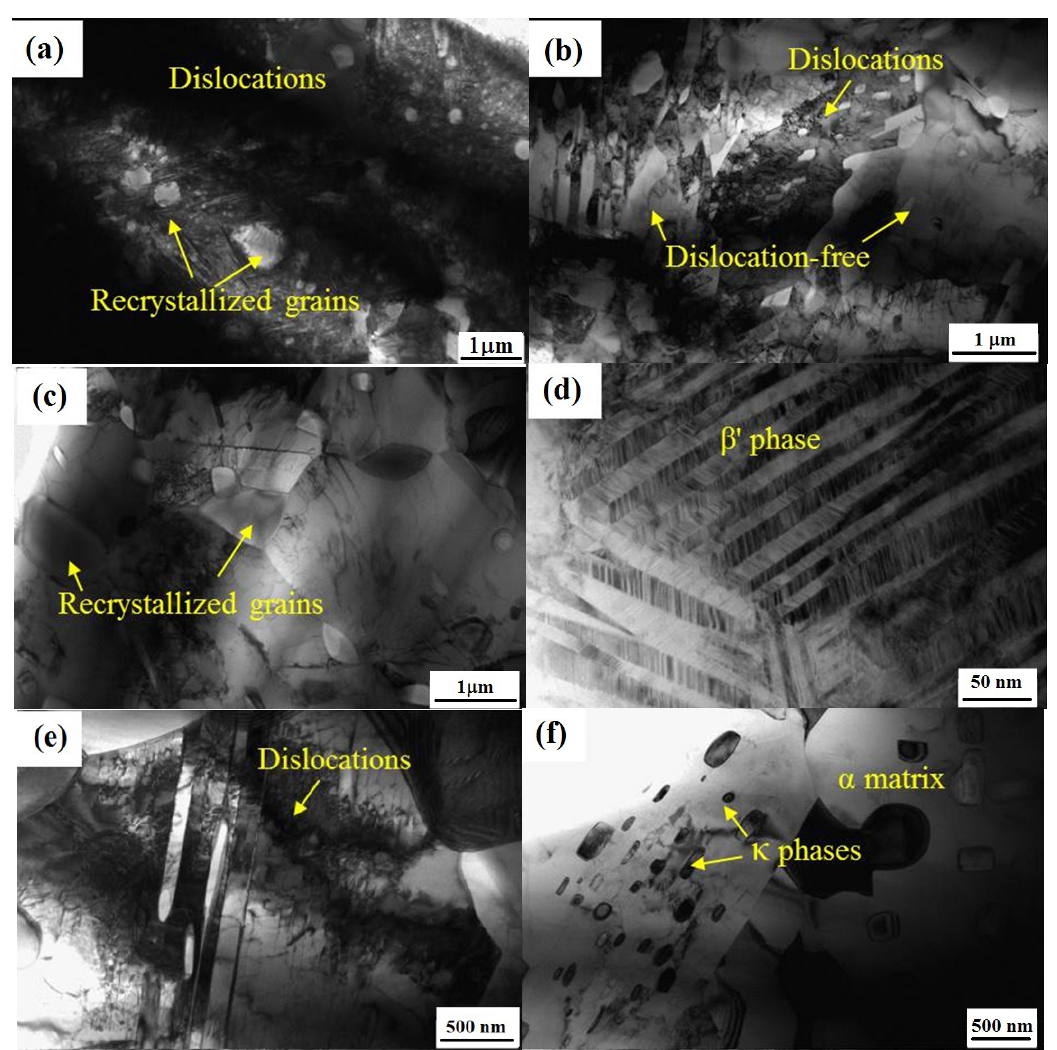
Figure 6. TEM images of ( a ) and ( d ) FSP NAB and post heat treated by annealing for: ( b ) and ( e ) 2 h, and ( c ) and ( f ) 4